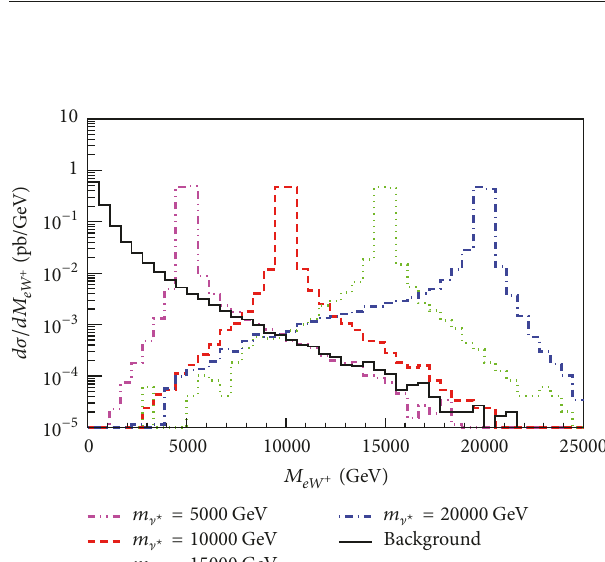
Figure 9: The invariant mass distributions of the excited neutrino signal and the corresponding background for Λ = 𝑚 ] ⋆ and 𝑓 = 𝑓 󸀠 = 1 at the PWFA-LC ⊗ FCC